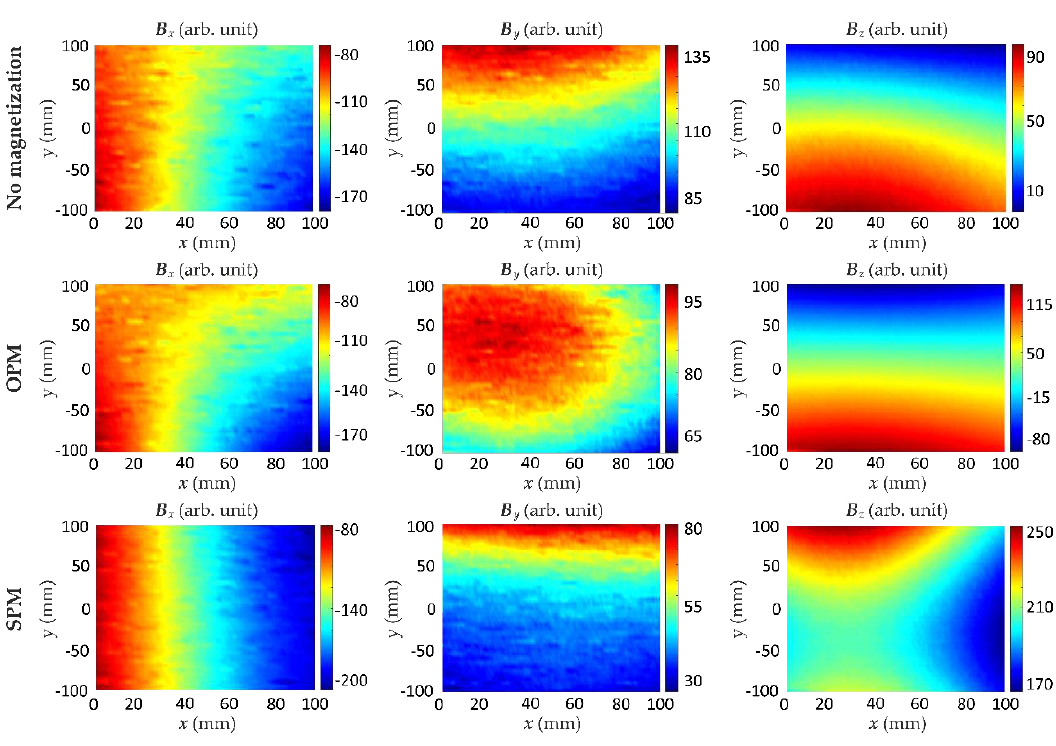
Figure 15. Results of 2D measurements using the AMR-sensor obtained for different variants of magnetization and different thicknesses h of concrete cover; experiment conducted for the sample S1 with single rebar; SPM — same pole magnetization, OPM — opposite pole magnetization; concrete cover thickness: ( a ) h = 20 mm; ( b ) h = 30 mm; ( c ) h = 50 mm; ( d ) h = 70 mm.